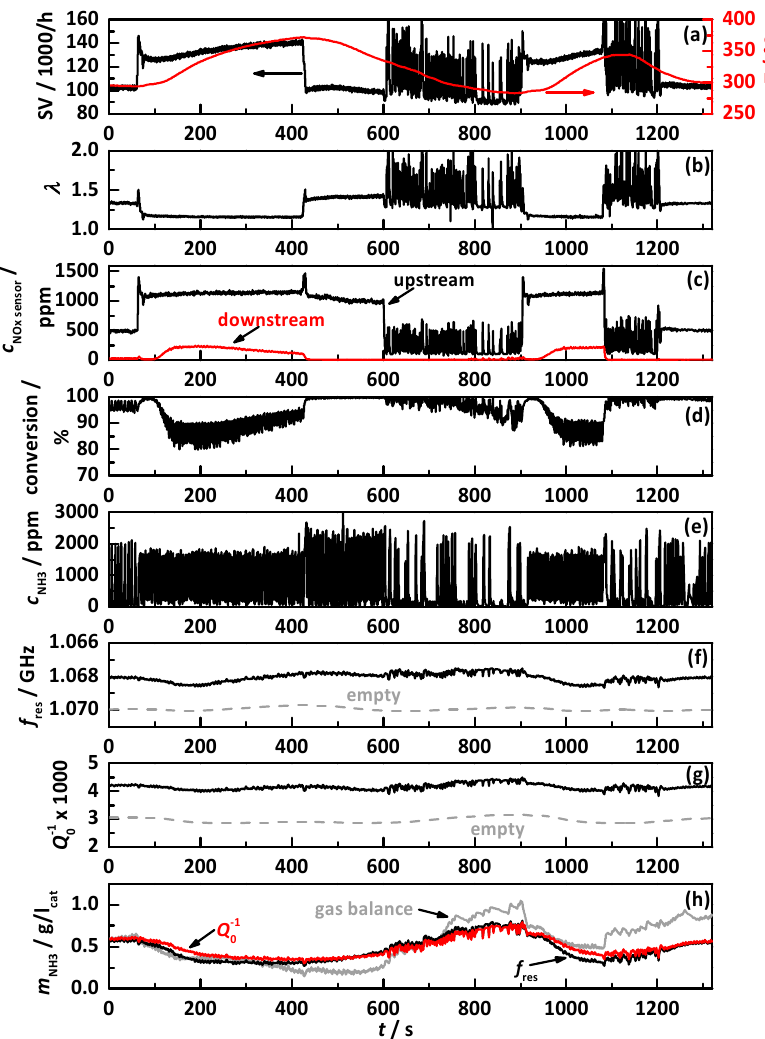
Figure 6. Test cycle with NH 3 storage control on 60% of the ideal storage curve by Q 0–1 with ( a ) the space velocity (black) and the catalyst temperature (red), ( b ) the air/fuel ratio λ , ( c ) the signals of the NO x sensors upstream of the DEF dosing (black) and downstream of the SCR catalyst, ( d ) the calculated apparent NO x conversion, ( e ) the dosed NH 3 determined by NO x sensors up- and downstream of DEF dosing, ( f ) f res and ( g ) Q 0–1 (black) with the calibration value for the NH 3 -free state (grey dashed), and ( h ) the amount of stored NH 3 on the catalyst determined by f res (black), Q 0–1 (red, control value), and by gas balance (grey).